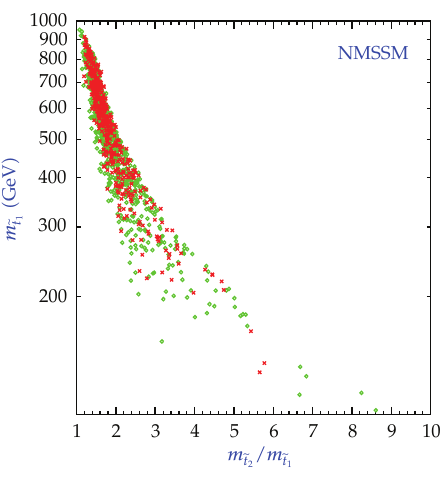
and the ratio t 1